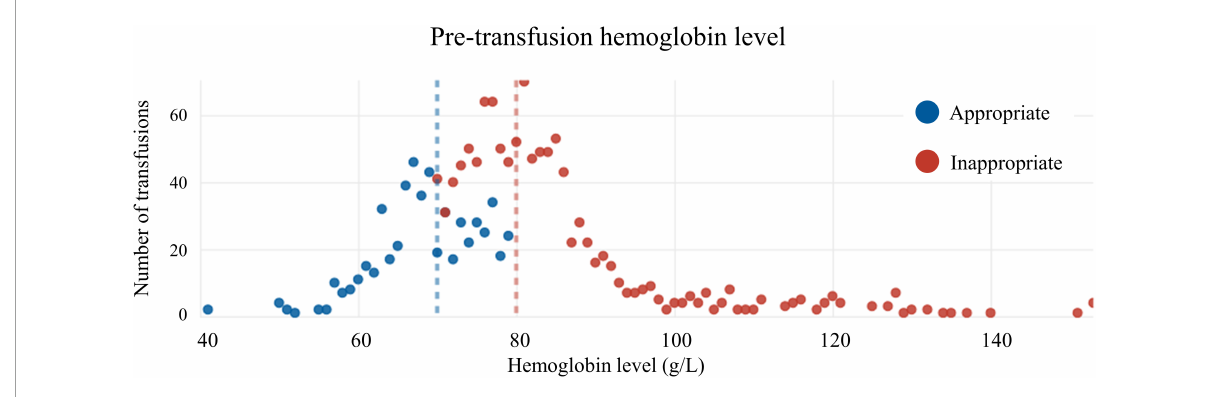
FIGURE2 Distribution of appropriate and inappropriate transfusions according to pre-transfusion hemoglobin